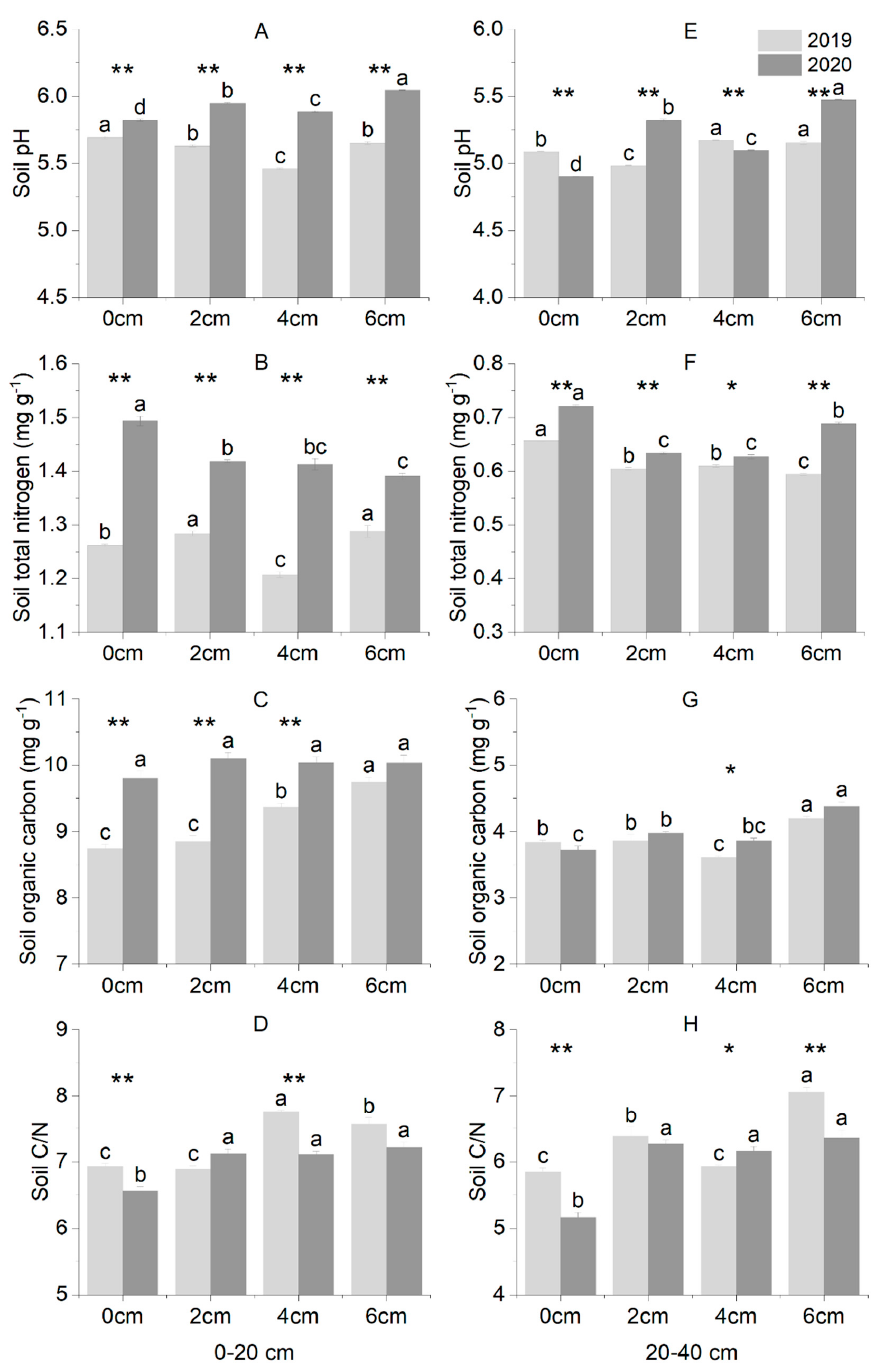
Figure 3. The effects of different treatments on soil properties. ( A )–( D ) represent the soil pH, total nitrogen, organic carbon and C/N of the 0 cm, 2 cm, 4 cm and 6 cm straw mulching treatments in the 0–20 cm soil layer in the two years, and ( E )–( H ) represent the soil pH, total nitrogen, organic carbon and C/N of the 0 cm, 2 cm, 4 cm and 6 cm straw mulching treatments in the 20–40 cm soil layer in the two years. Different lowercase letters indicate significant differences among different treatments at p < 0.05 level, with * indicating significant differences in the same treatment at p < 0.05 level between the different years, and ** indicating significant differences in the same treatment at p < 0.01 level between the different years. Mean values ± standard error, n =